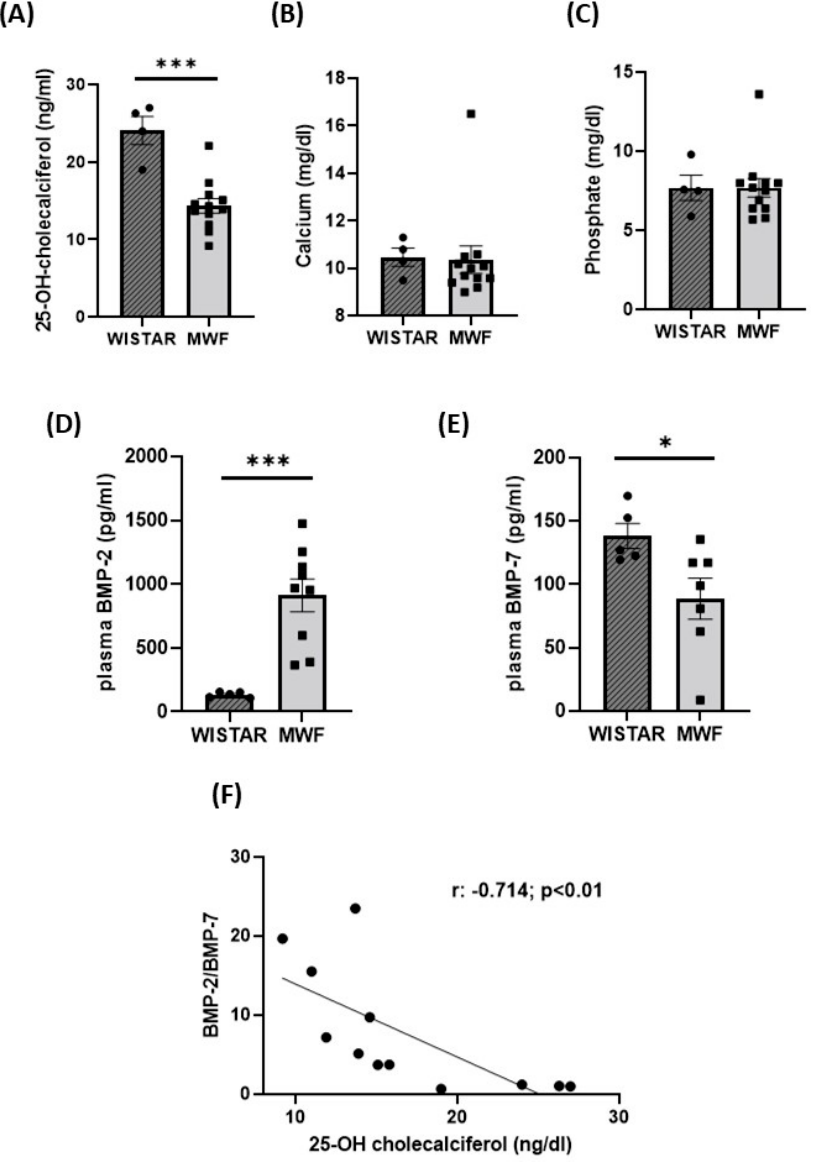
CKD patients with atrial fibrillation (n = 5) showed a significant BMP-2/BMP-7 imbalance with significantly higher ( p < 0.05) BMP-2 and lower ( p < 0.07, non-significant) BMP-7 concentrations compared with CKD patients without atrial fibrillation (Figure 1G,H). The level of 25-OH-cholecalciferol in those patients was of 15.63 ng/mL, p < 0.07. 2.3. MWF Rats Show an Imbalance in Plasma BMP Levels Associates with 25-OH-Cholecalciferol Deficiency Plasma 25-OH-cholecalciferol levels were significantly lower in MWF than in Wistar rats (Figure 2A). No changes in calcium (Figure 2B) or phosphate (Figure 2C) levels were detected between groups. Plasma BMP-2 concentrations were significantly higher (Figure 2D), whereas BMP-7 was lower in MWF compared to Wistar rats (Figure 2E). Plasma 25-OH- cholecalciferol concentration negatively correlated with the BMP-2/BMP-7 plasma ratio.